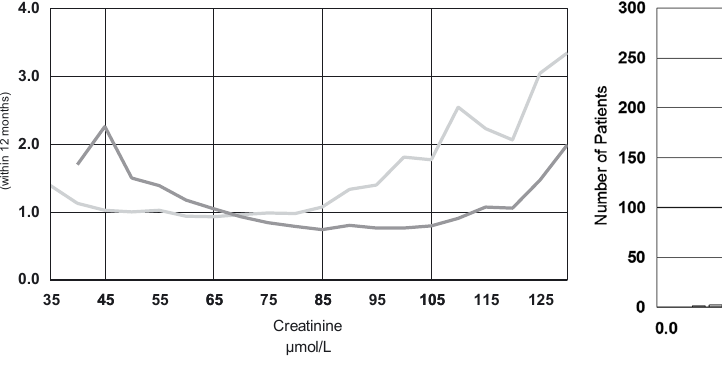
Figure 2: Relative likelihood of repeat testing within 12 months of serum creatinine against the initial creatinine result for 530,000 women (light coloured line) and 430,000 men (dark coloured line). The creatinine reference interval for women (Roche enzymatic method) is 45 – 85 μ mol/L for women and 65 – 105 μ mol/L for men.